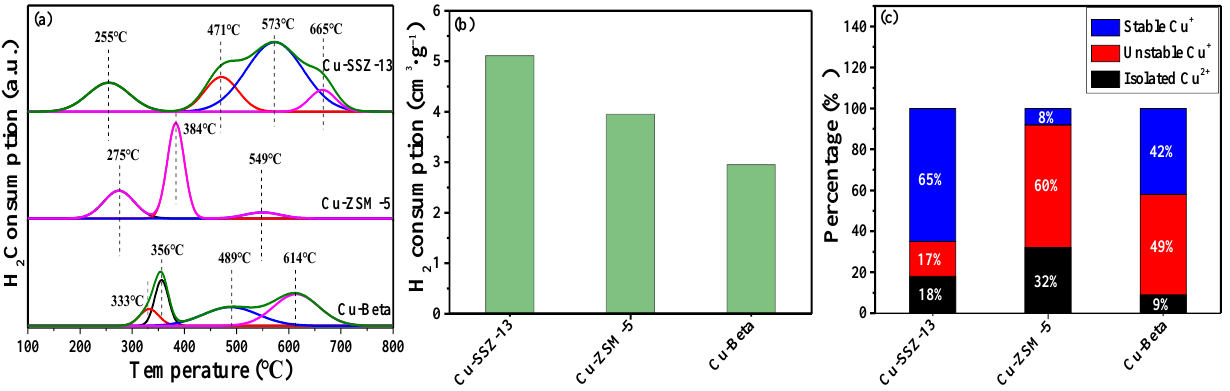
Figure 7. H 2 -TPR patterns ( a ), H 2 consumption ( b ) and proportion of different Cu species ( c ) for the copper-based zeolites.